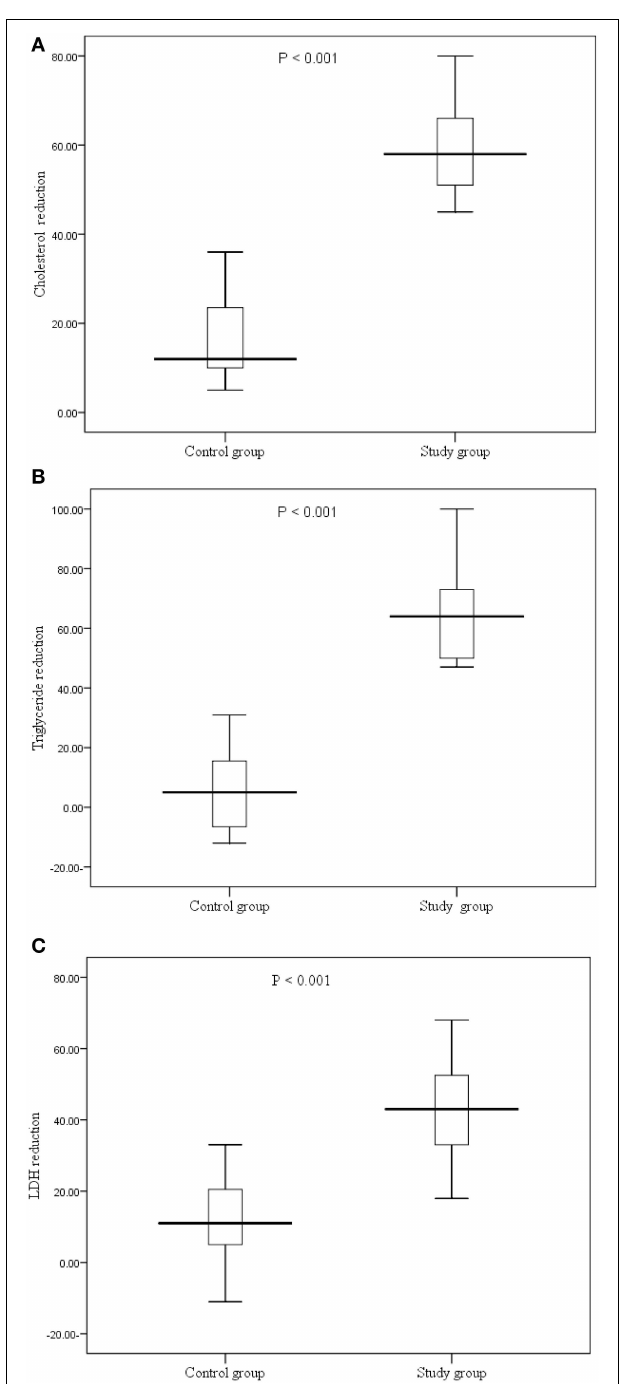
FIGURE 2 | (A–C) Reduction of the lipids (cholesterol, triglyceride and LDL profile in the study and control groups before and after the